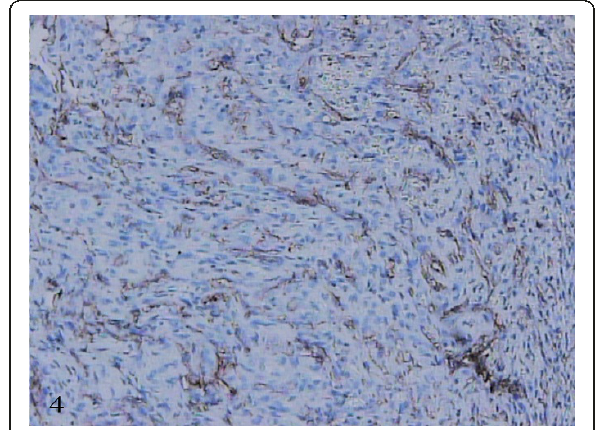
Figure 4 Flattened cells, positive for anti-CD31 monoclonal antibody . The vascular spaces are delineating within the tumoral nodule. Immunostaining, original magnification × 25.